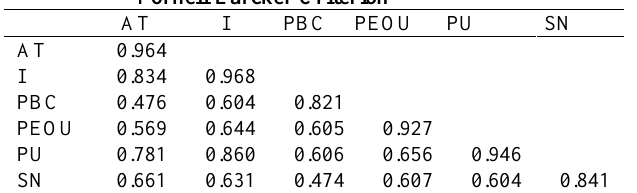
Table 3: Discriminant Validity Analysis based